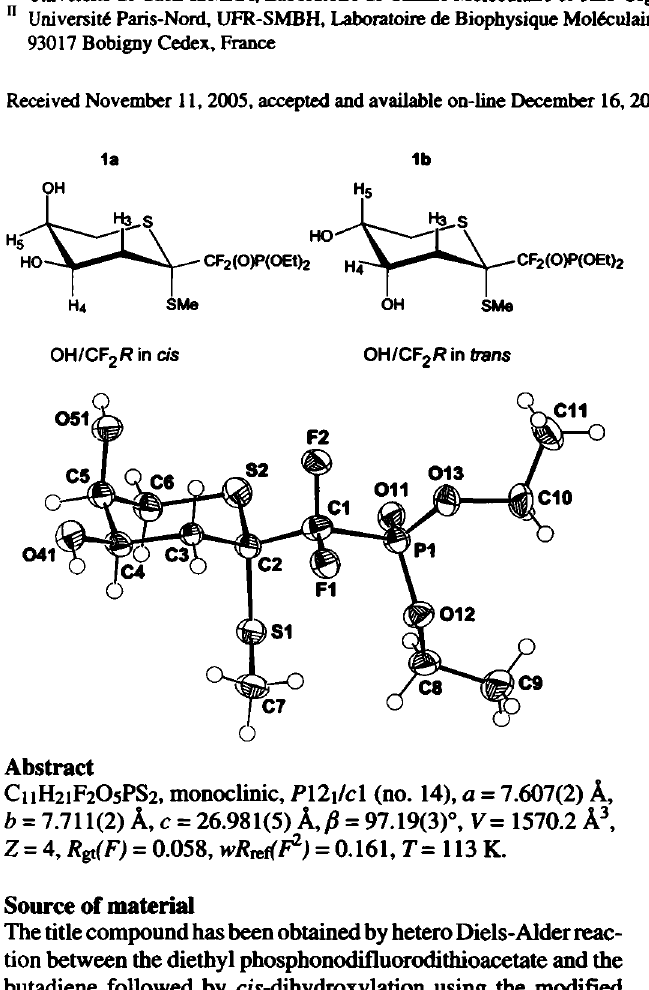
Table 2. Atomic coordinates and displacement parameters (in Ä 2